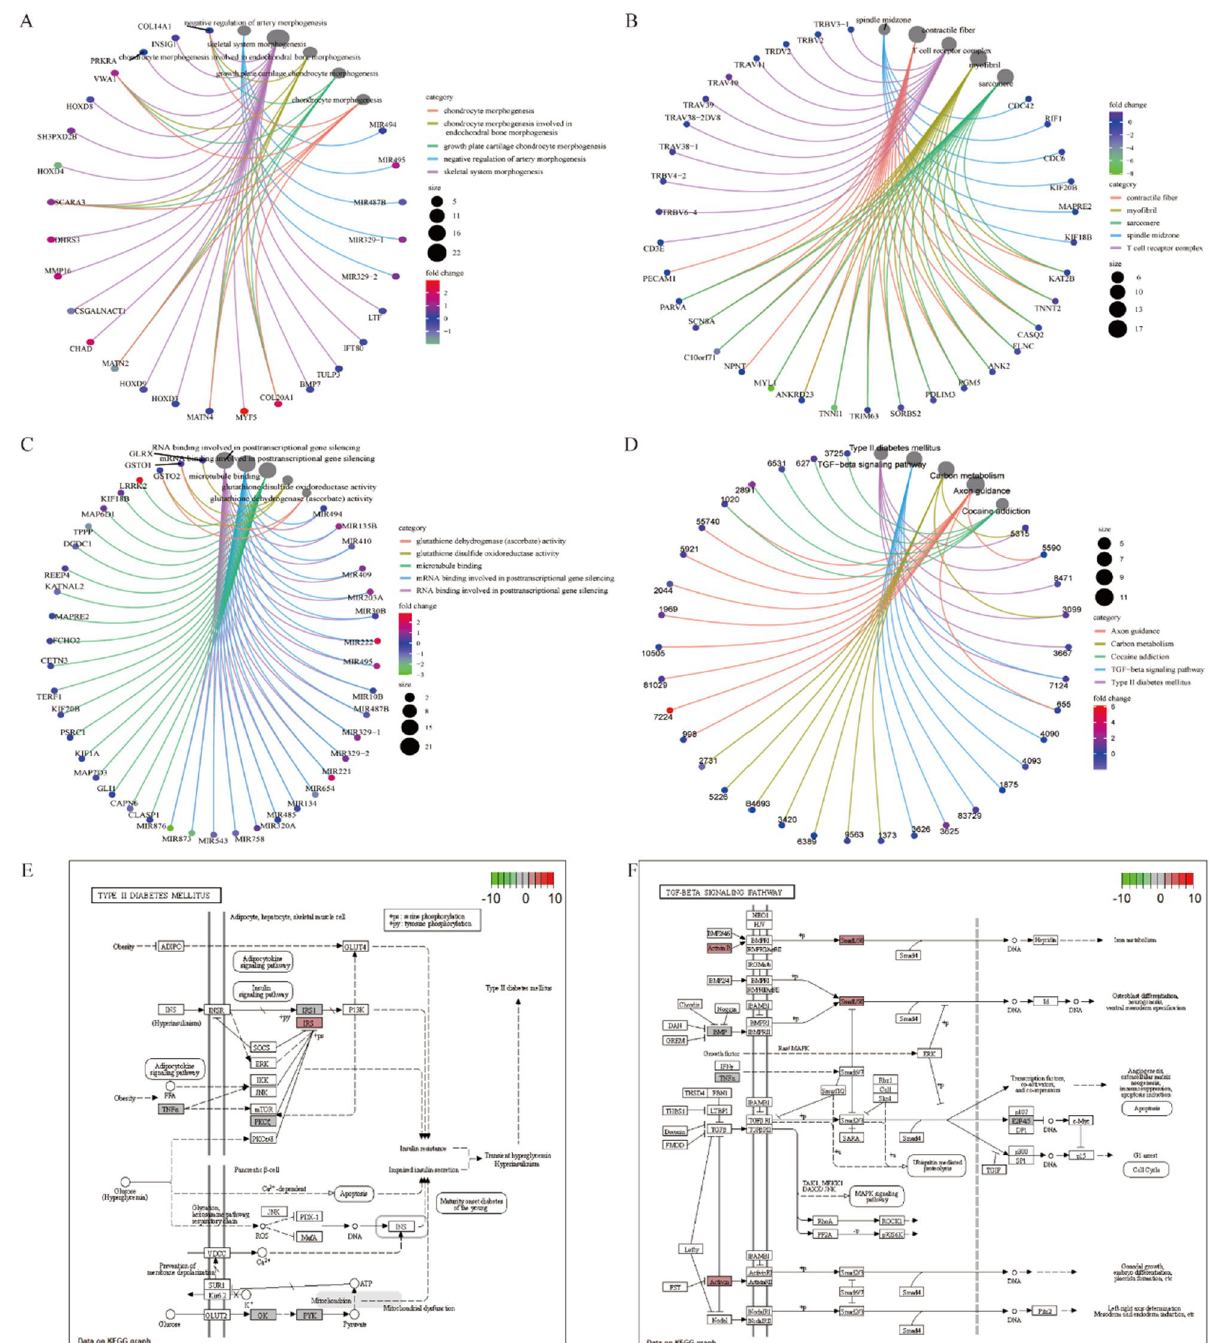
Figure 2. Functional enrichment analysis of cis-target genes based on differential lncRNAs. ( A – C ) Based on the three GO classifications (CC, BP, and MF), our analysis suggests that the expression of cis-target genes is related to several terms, such as negative regulation of artery morphogenesis, spindle midzone, RNA binding involved in post-transcriptional gene silencing, and other biologically related processes. ( D ) KEGG enrichment analysis indicates that the expression of cis-target genes is significantly associated with different pathway terms, such as type II diabetes mellitus, the TGF-beta signaling pathway, and other pathways. ( E , F ) Visual display of changes in the relevant enriched